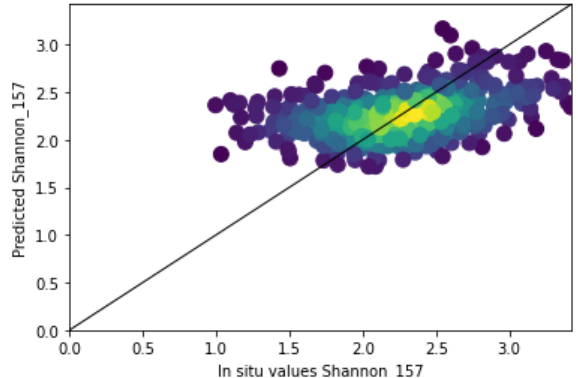
Figure 6: Scatter plot of predicted vs. in situ Shannon index in